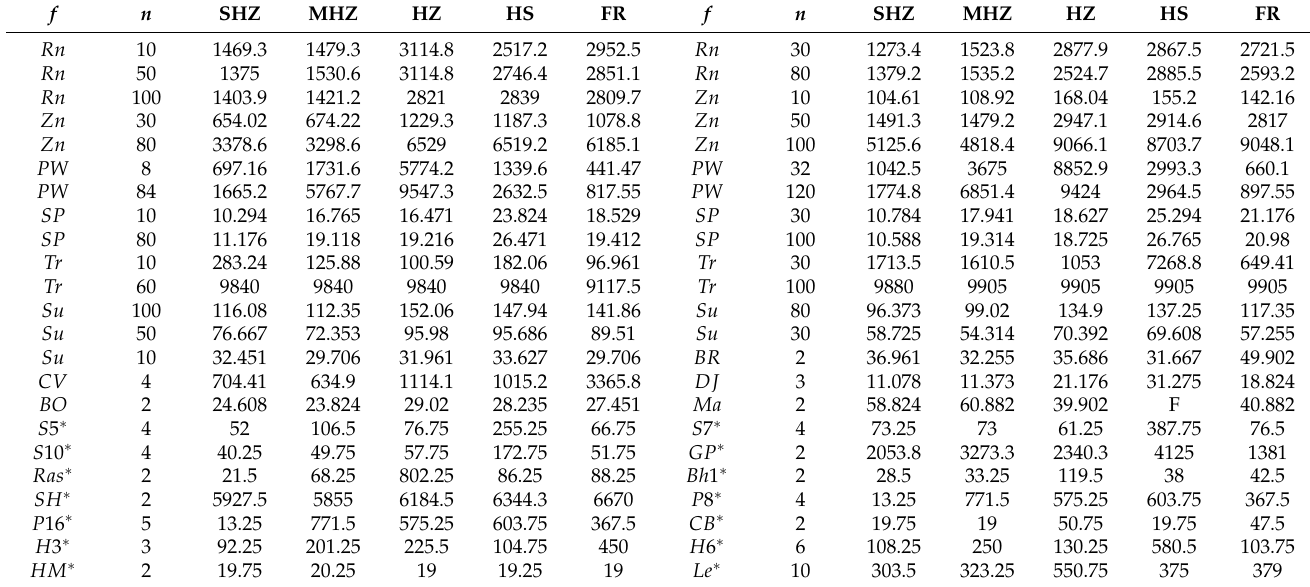
Table 7. The average of number of iterations.